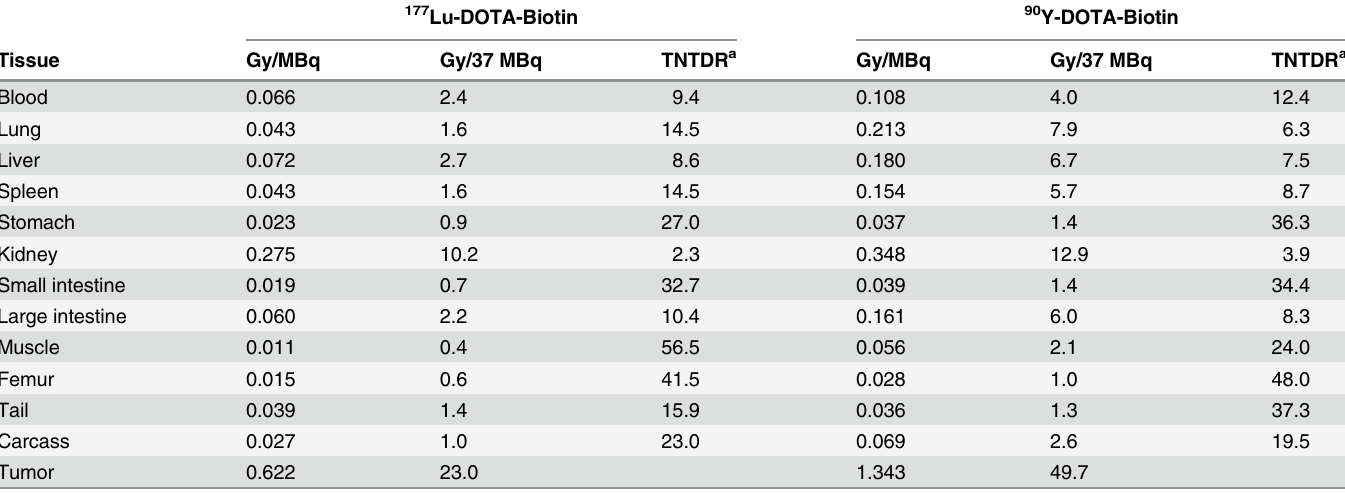
Table 2. Mean radiation absorbed doses from radiolabeled DOTA-biotin in Ramos-xenografted mice pretargeted with 1F5-SA. 177 Lu-DOTA-Biotin 90 Y-DOTA-Biotin